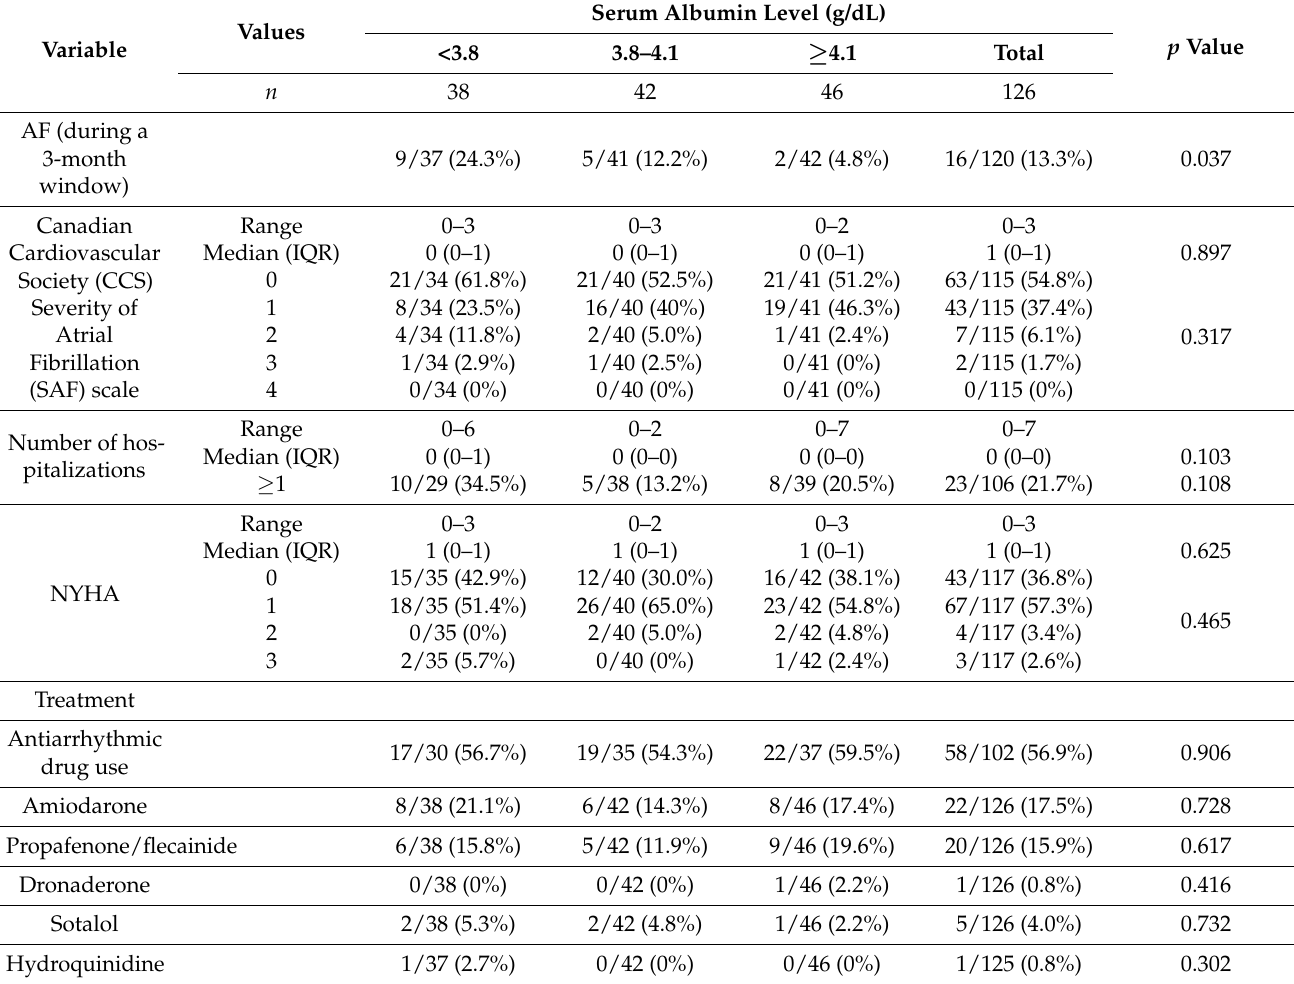
Table 4. Follow up characteristics by serum albumin (SA) level